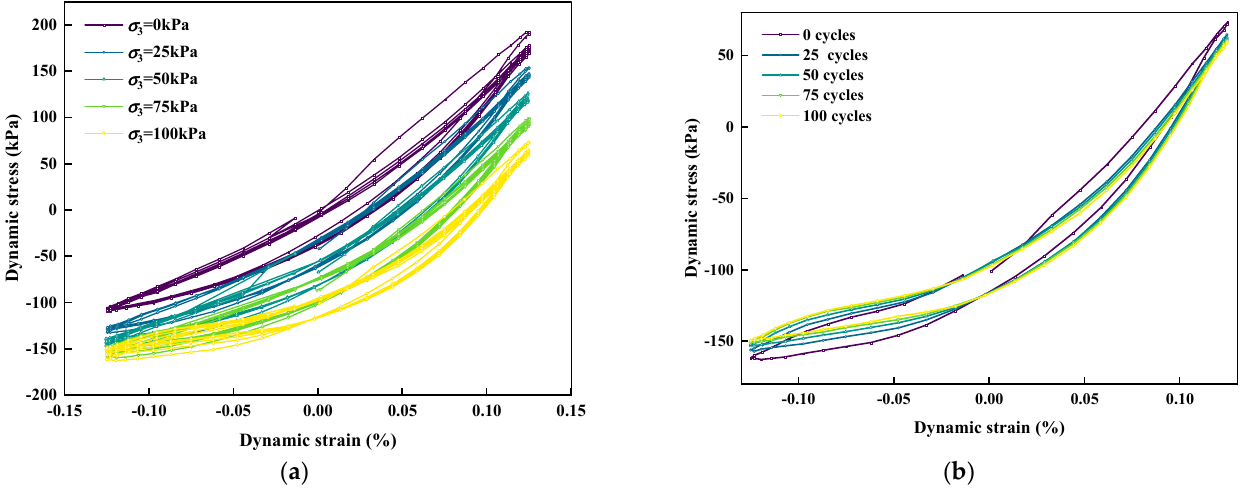
Figure 14. Hysteretic curve under different confining pressure and different numbers of cycles: ( a ) Stress − strain curves under cyclic loading with different confining pressures; ( b ) variation diagram of the hysteretic curve with cycle count under a confining pressure of 100 kPa.